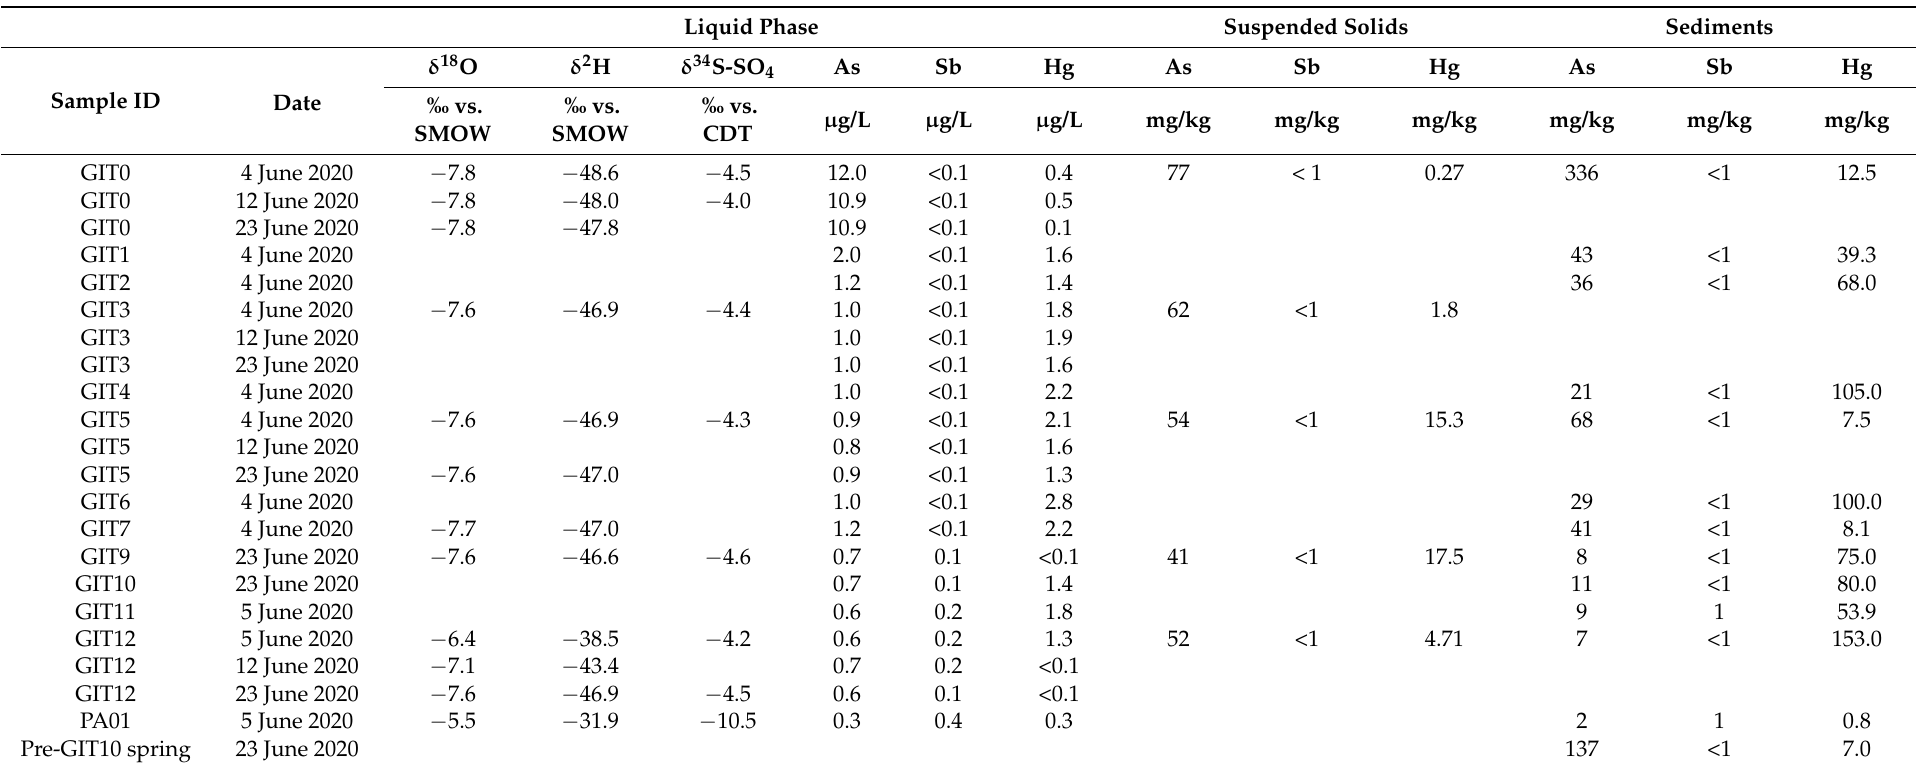
Table 2. Oxygen and hydrogen isotopes in water (expressed as δ 18 O and δ D vs. ‰ V-SMOW, respectively) as well as sulfur isotopes (in SO 42 − ; expressed as δ 34 S vs. ‰ VCDT) and As, Sb, and Hg concentrations in water (in µ g/L), selected suspended solids, and stream sediments (in mg/kg) from the FdC and Pagliola